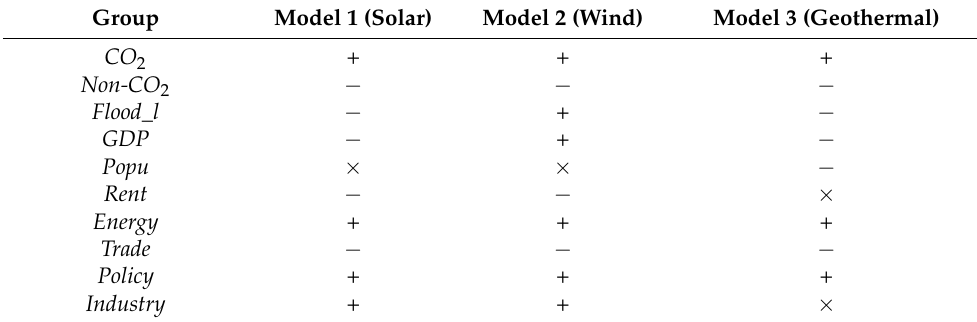
Table 6. Overview of the